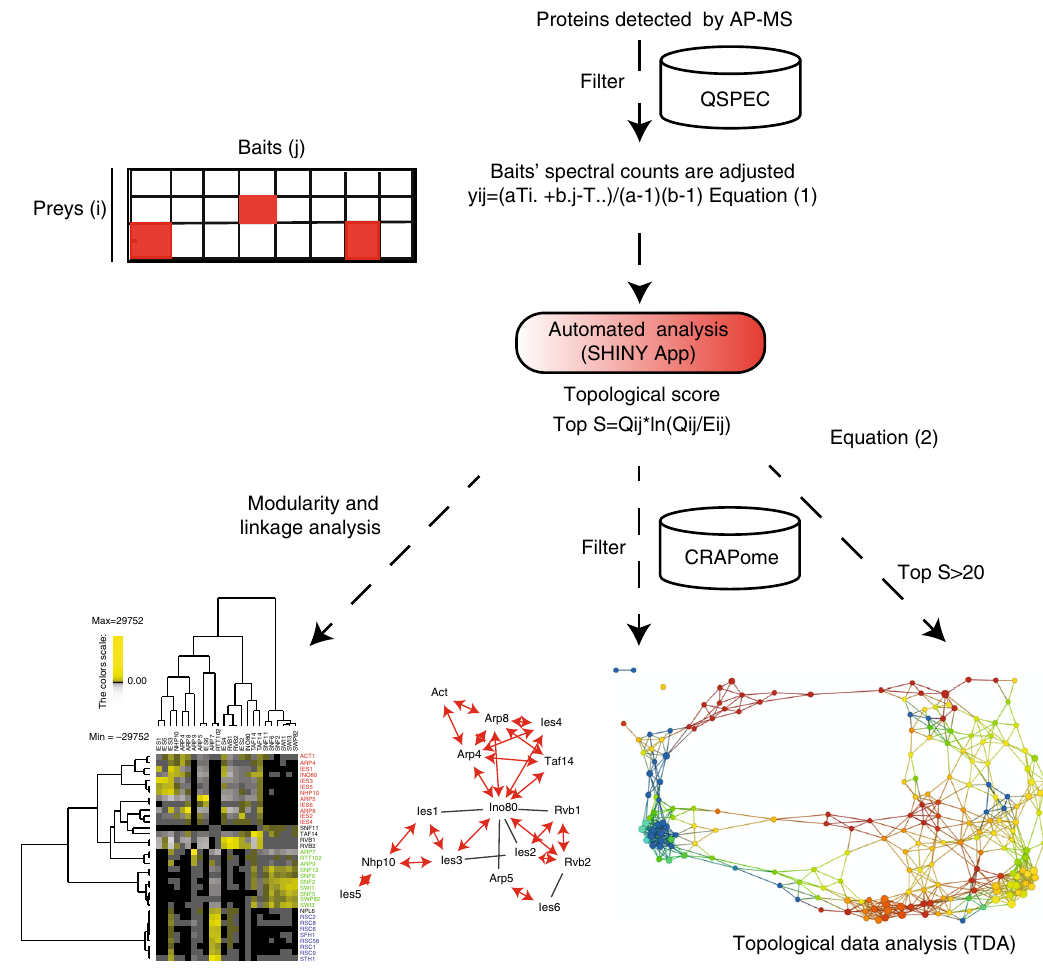
Fig. 1 Work fl ow for topological scoring of protein interaction datasets. In the fi rst step, contaminant proteins are fi ltered using Z scores and FDR generated from QSPEC; however, other approaches could be used. Next, overexpressed bait proteins that have high spectral counts in the data are adjusted using Eq. (1). After prey proteins as baits are adjusted, topological scores (TopS) are then calculated, using an automated SHINY application, as described in Eq. (2), where Q ij is the observed count in row i and column j and E ij is the expected count in row i and column j . Direct input of TopS values can be used in many different ways, such as data clustering to investigate the modularity and linkage in a network; additional fi ltering may be conducted using the CRAPome 27 , for example; and a topological data analysis network may be generated. FDR false discovery